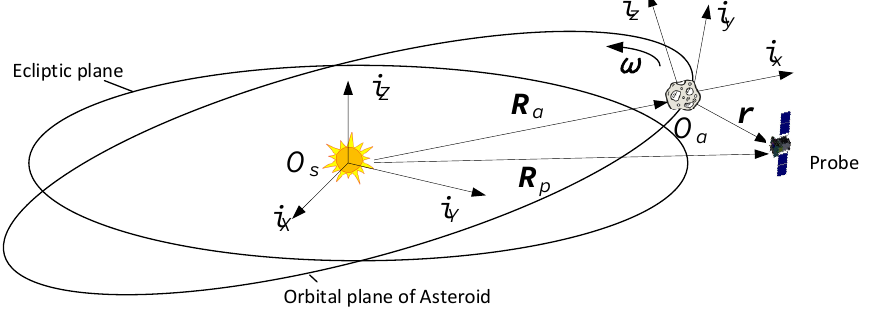
Figure 1. Definition of asteroid Hill rotation coordinate